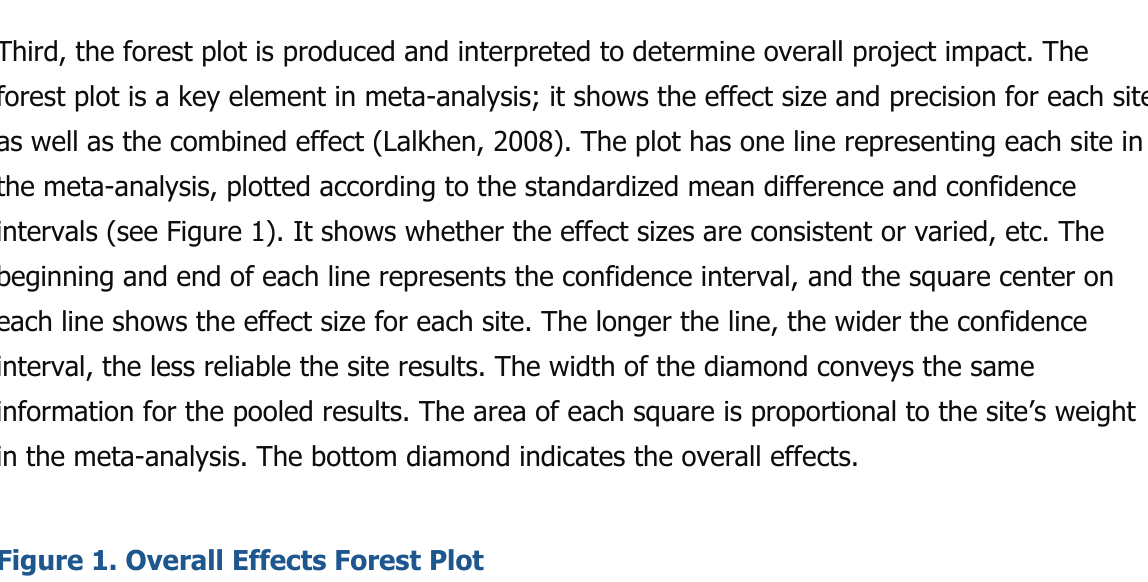
Figure 1. Overall Effects Forest